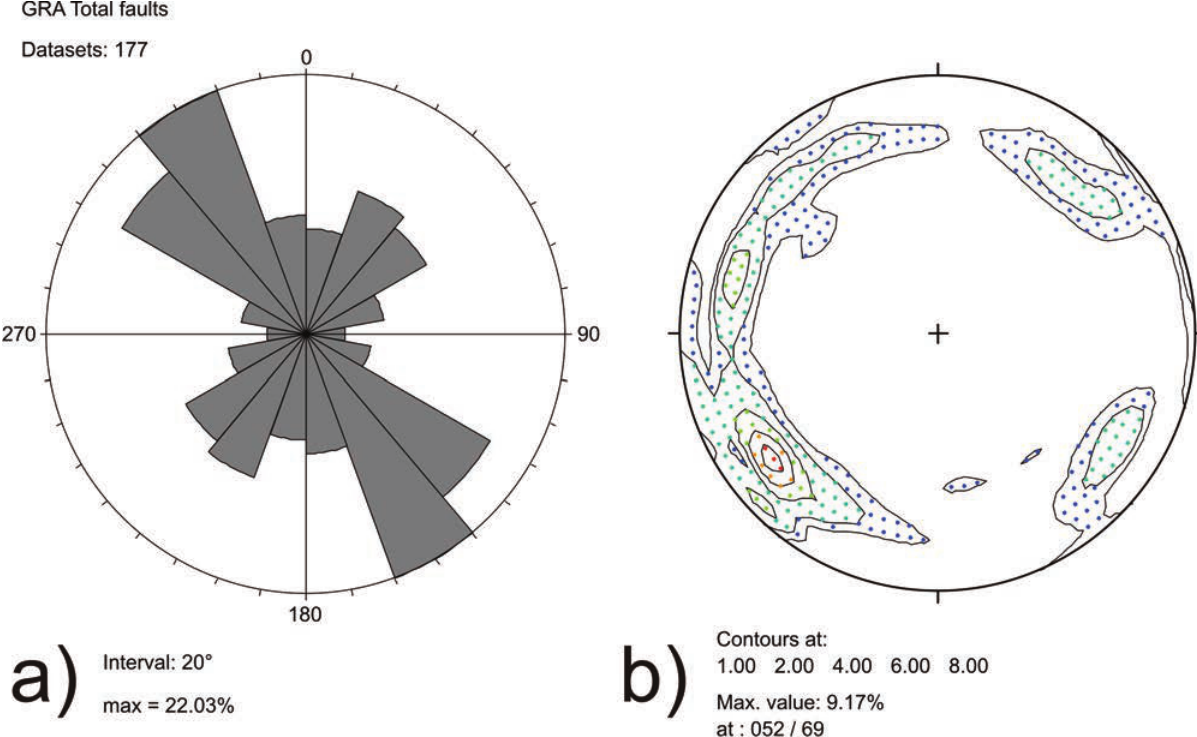
Figure 10. Geometry of all analyzed faults: a) Circular histogram of unweighted frequencies of fault plane directions; b) fault poles density contour plot (lower hemisphere; Schmidt net); TectonicsFP software® [Ortner et al. 2002].